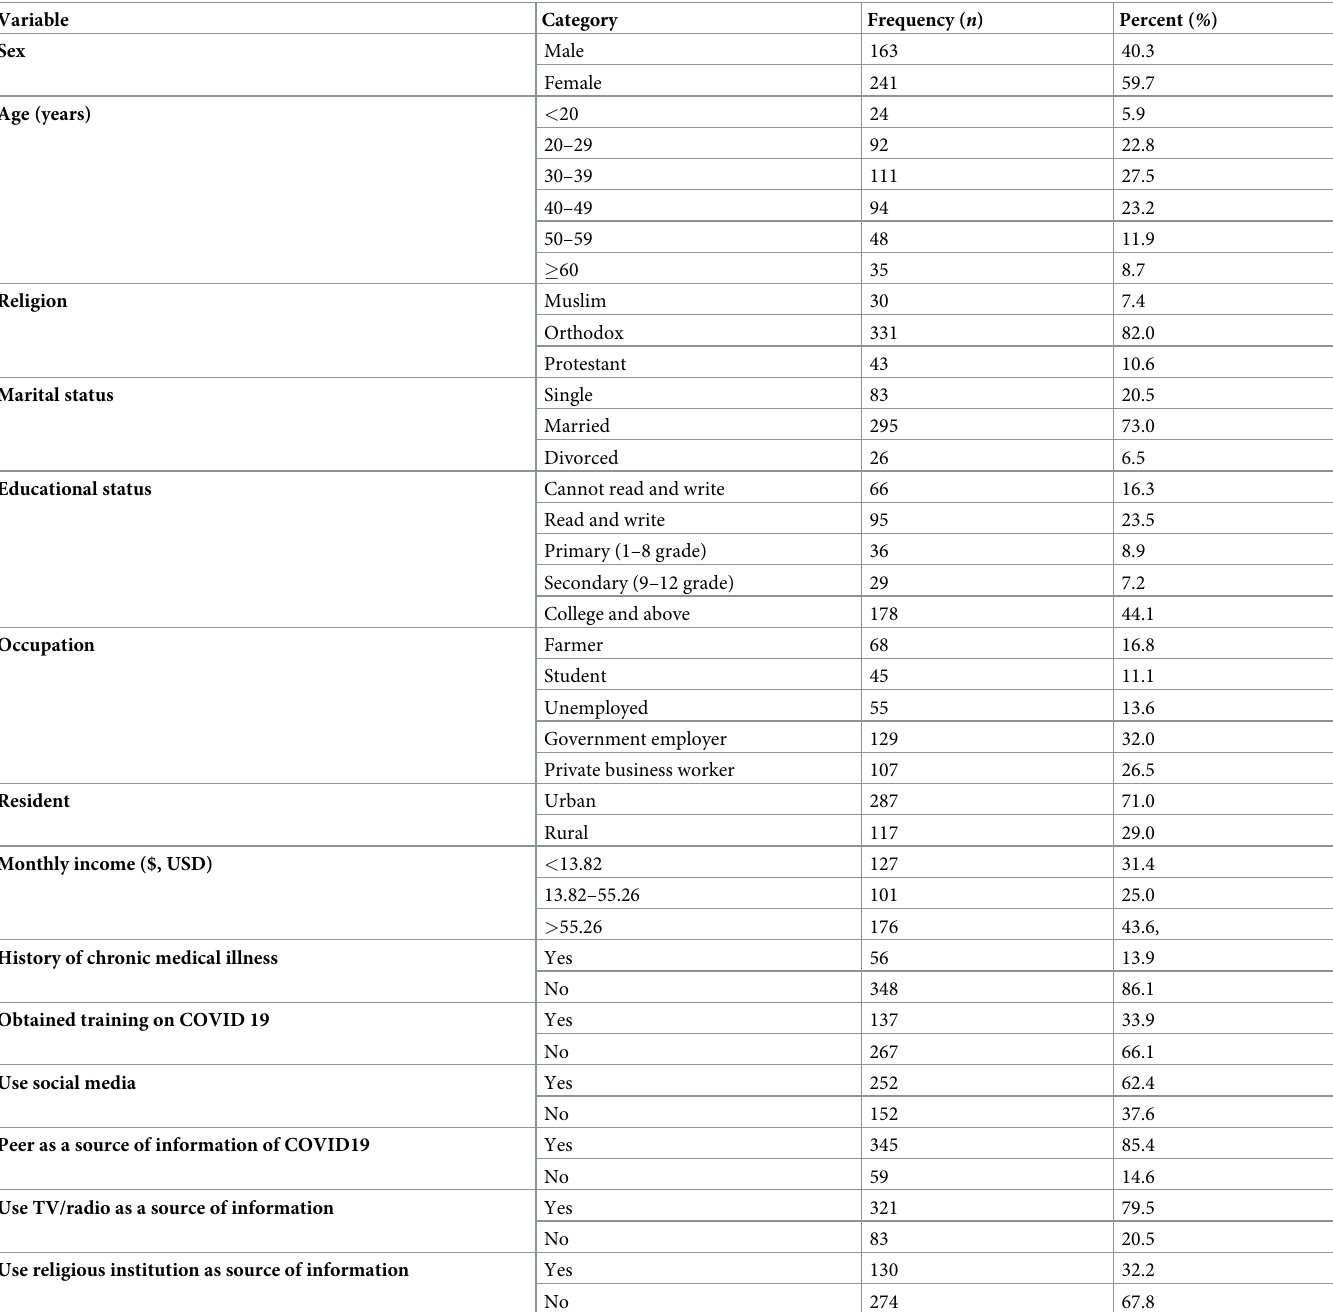
Table 1. Socio-demographic characteristics of adult visitors in hospitals of South Gondar zone Northwestern Ethiopia, August 1 to 30,